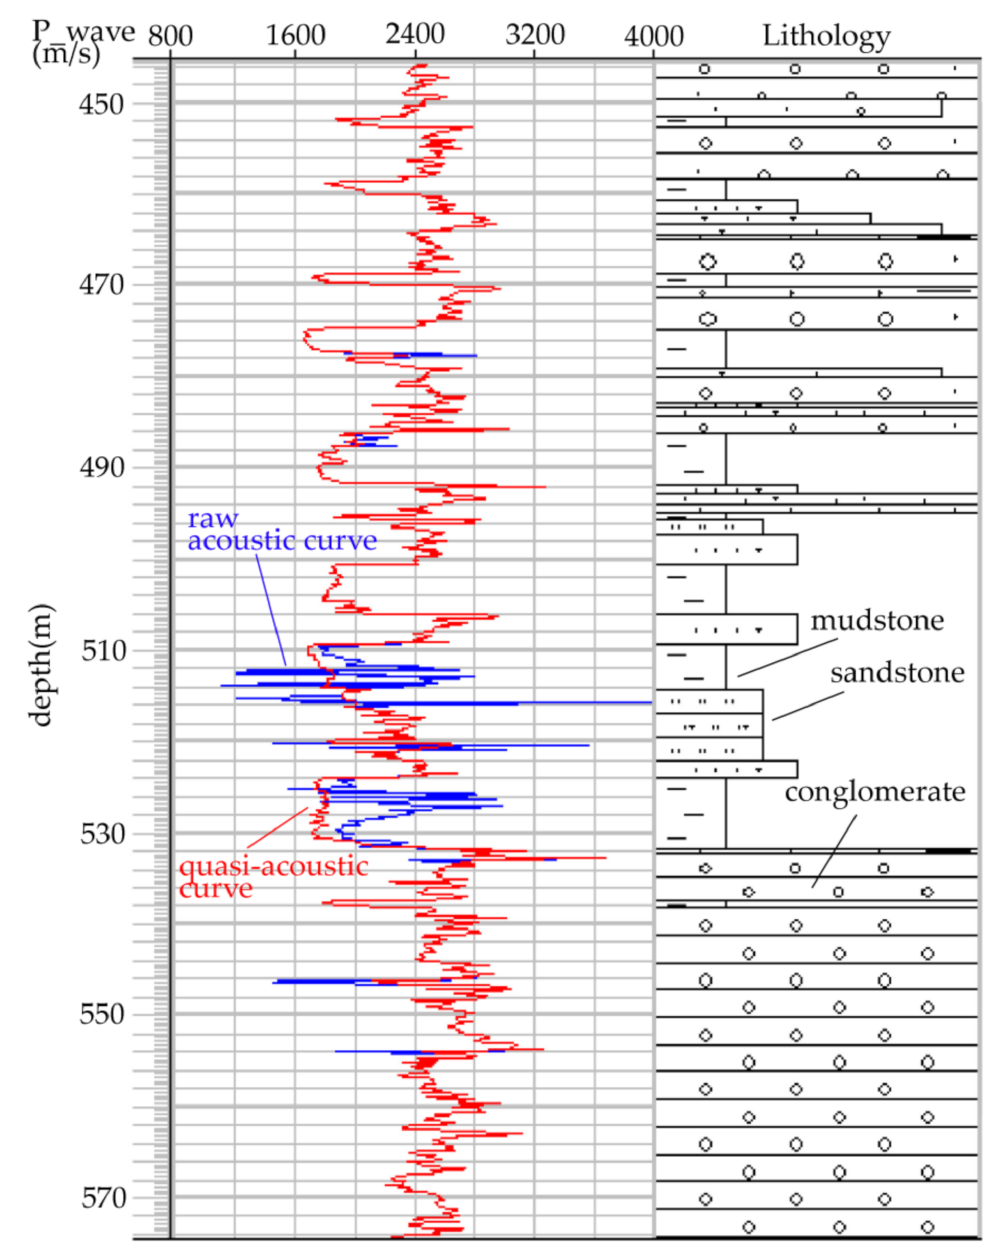
Figure 4. The comparison of the raw acoustic curve and the quasi-acoustic curve for a typical borehole in the 3D seismic study